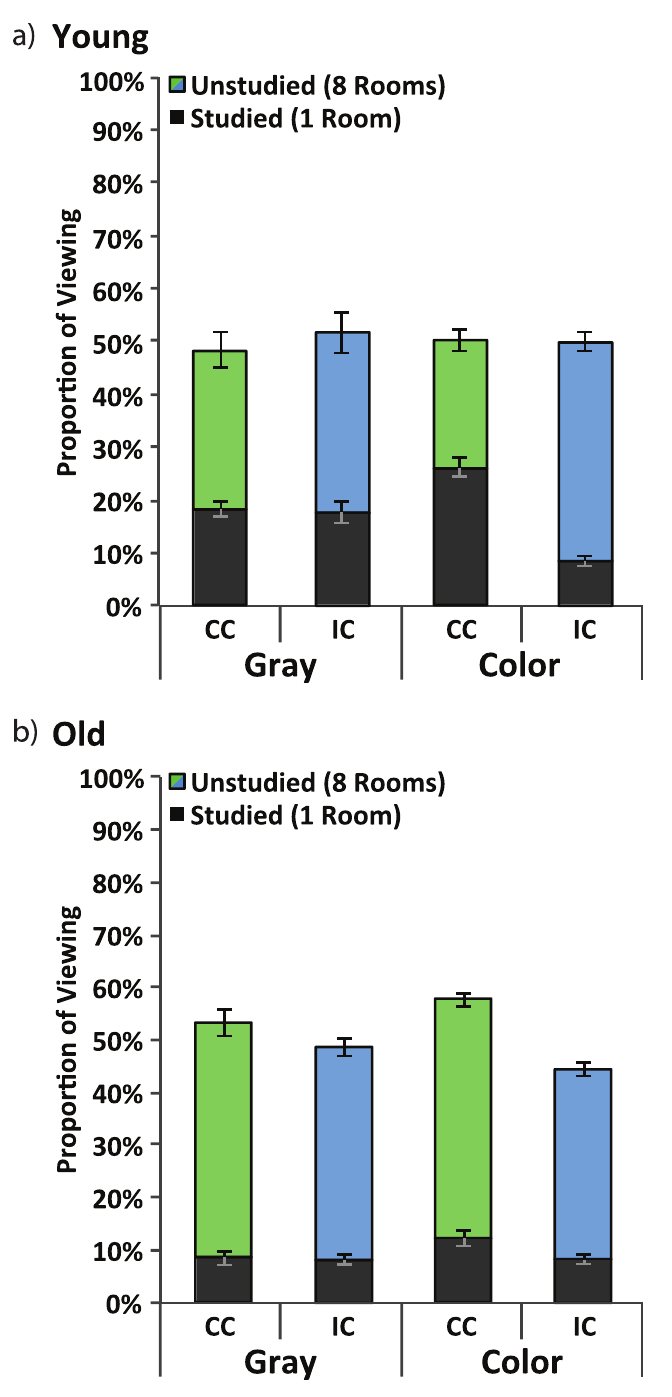
Fig 7. Eye-movement data. Proportion of viewing to rooms on the correct (green) and incorrect (blue) side of the building. Dark bars indicate face placements to the studied room on a given side whereas colored (green or blue) bars indicate face placements to any of the remaining eight unstudied rooms. Data are presented for both the Young Adult (a) and Older Adult (b) groups for both the gray building and color building viewing period; standard error bars are